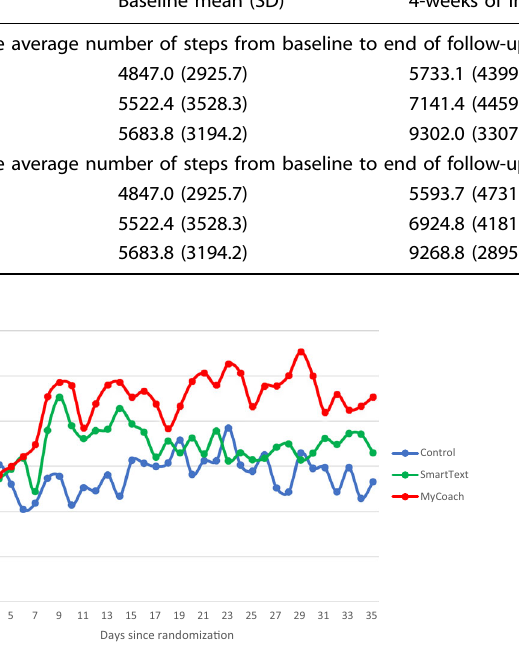
Table 2. Change in average number of daily steps (follow-up minus baseline) within each arm. Groups